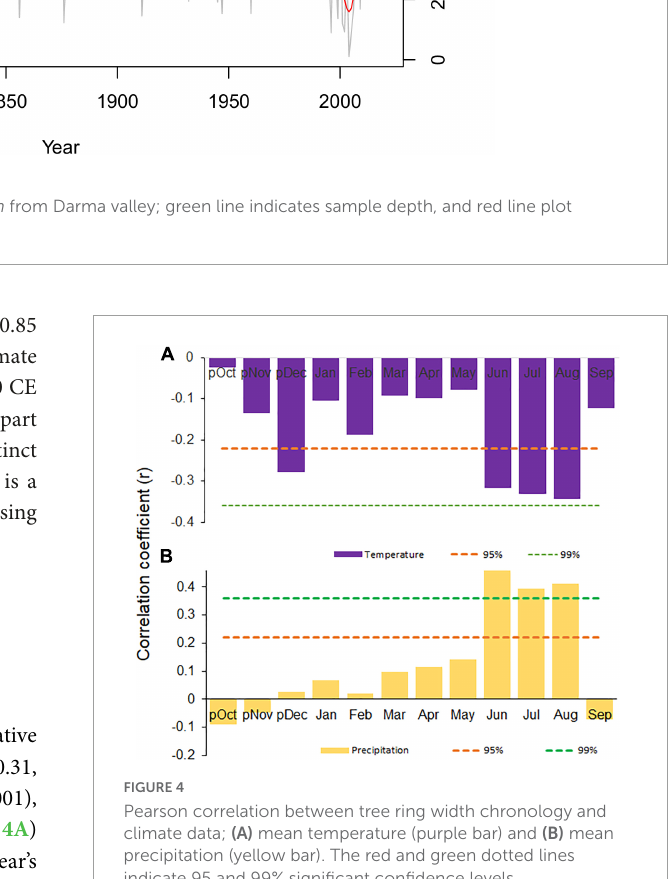
FIGURE4 Pearson correlation between tree ring width chronology and climate data; (A) mean temperature (purple bar) and (B) mean precipitation (yellow bar). The red and green dotted lines indicate 95 and 99% significant confidence